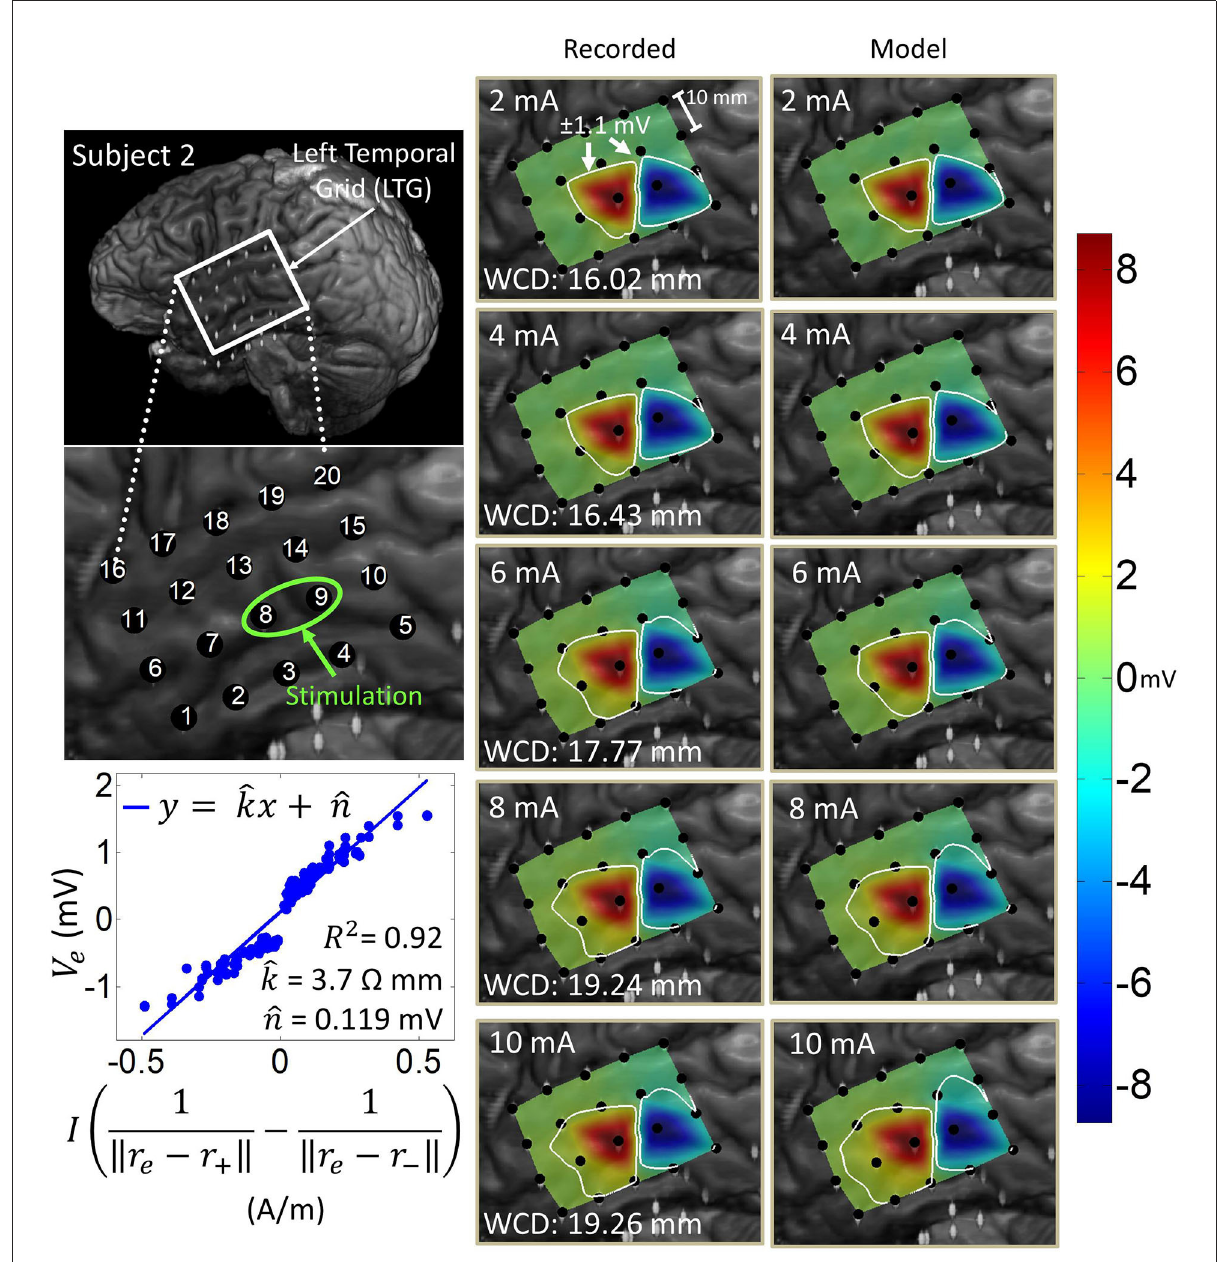
FIGURE6 Artifact spatial maps for recorded ECoG data and model predictions for subject 2. (Top left) Co-registration image showing the representative grid over the left temporal lobe. (Bottom left) Regression uses ECoG data from 2 to 10 mA stimulation amplitudes on the stimulation channel LTG8-9. Artifact spatial maps were generated using values from the recorded data (middle) the dipole model (right) . Electrodes LTG19 and LTG20 contained no recorded ECoG data, so they are excluded from the analysis (values on the recorded data map are imputed from electrode